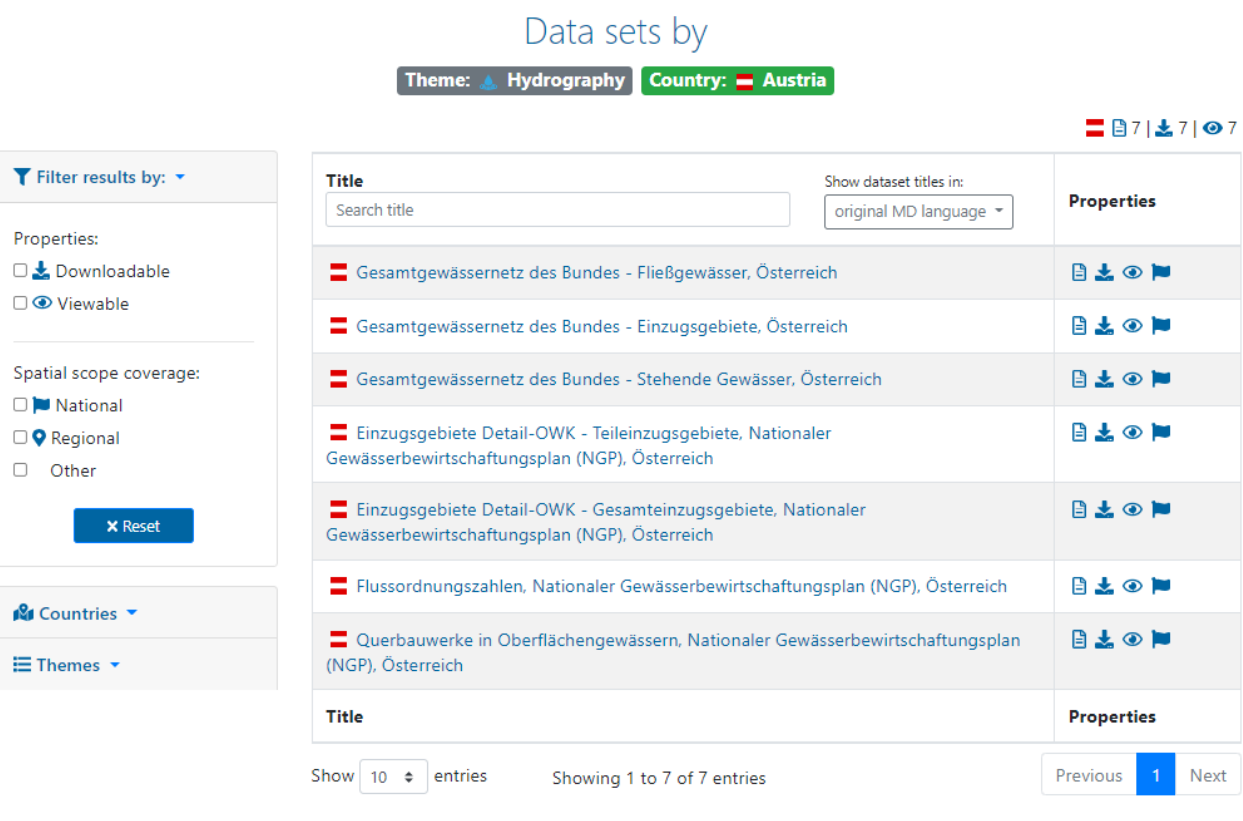
Figure 7. Available hydrography datasets in Austria. Source: European Commission, Joint Re- search